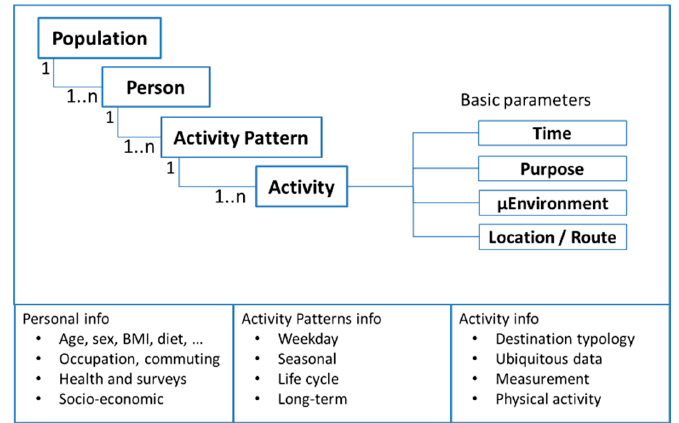
Figure 2. Personal objects structure and examples of the objects attribution.